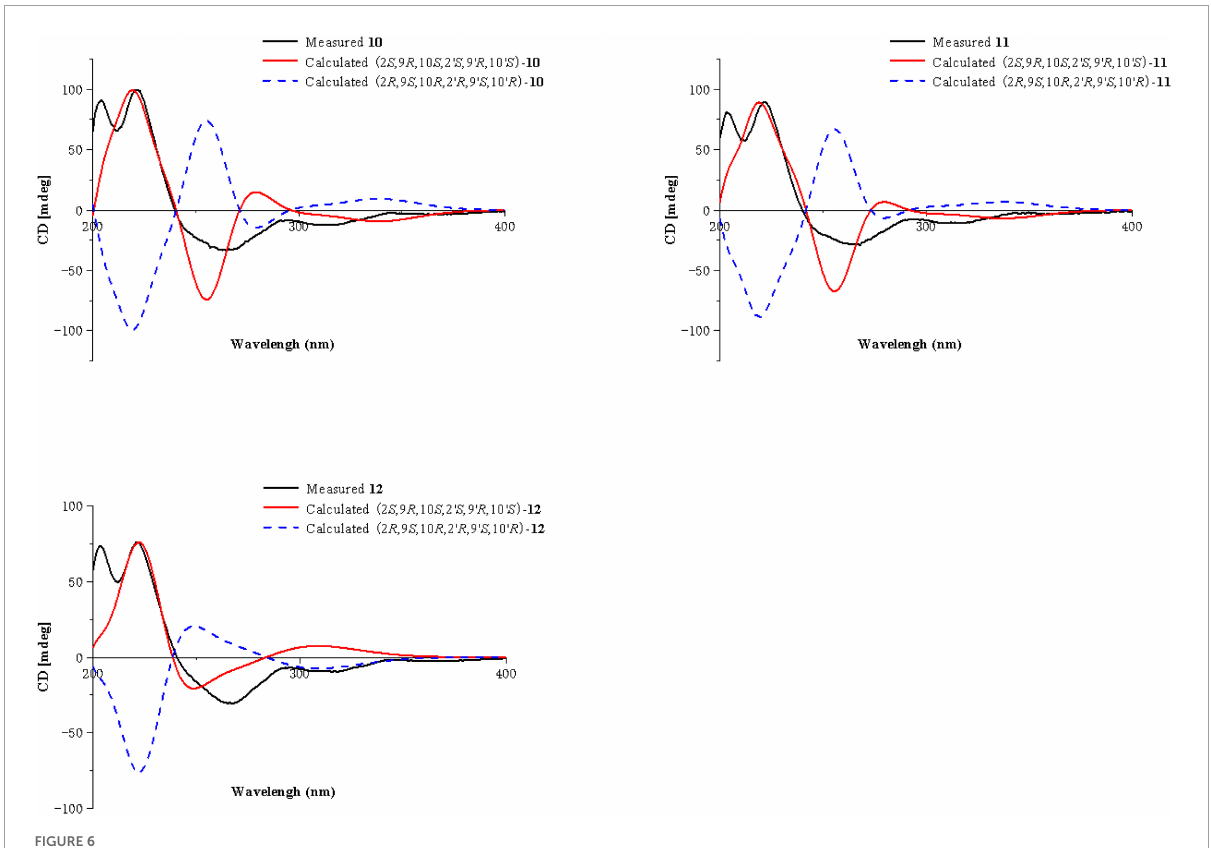
FIGURE6 ECD calculations of 10 – 12